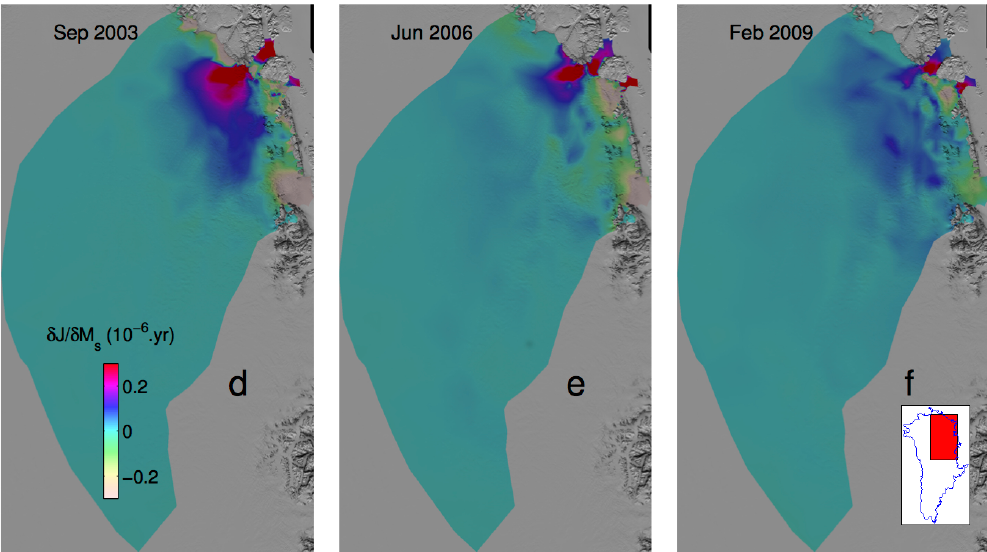
Figure 3. Gradient of the surface altimetry cost function (spatio-temporal average of the misfit between the 6-year record of observed ICESat altimetry and modeled surface elevation) with respect to SMB (in years). The gradient is computed for every time step of a 2-week interval time series between 2003 and 2009. We only show three periods (September 2003, June 2006, and February 2009) in the entire interval. The location for the study is the northeastern Greenland Ice Stream, and the gradient is taken from an inversion study of the surface forcings necessary to best fit the ICESat altimetry record (Larour et al., 2014).